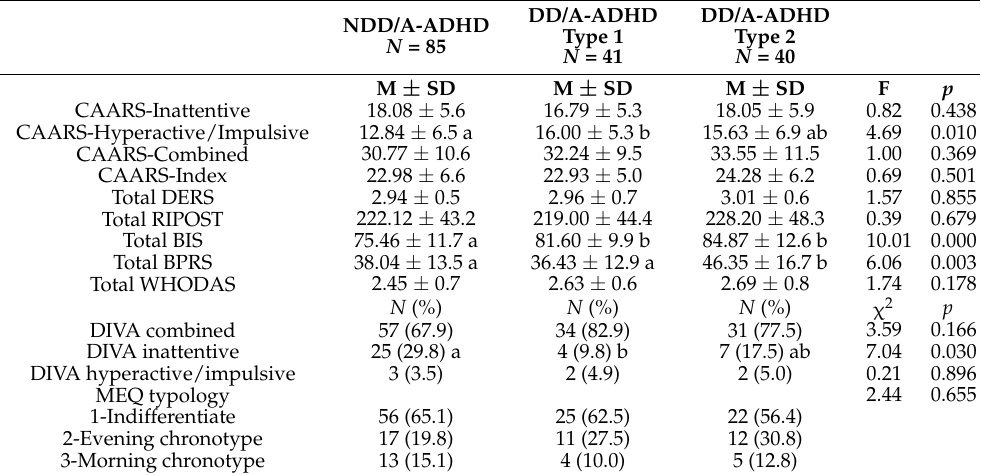
Table 2. Demographic and clinical differences in A-ADHD patients with and without Dual